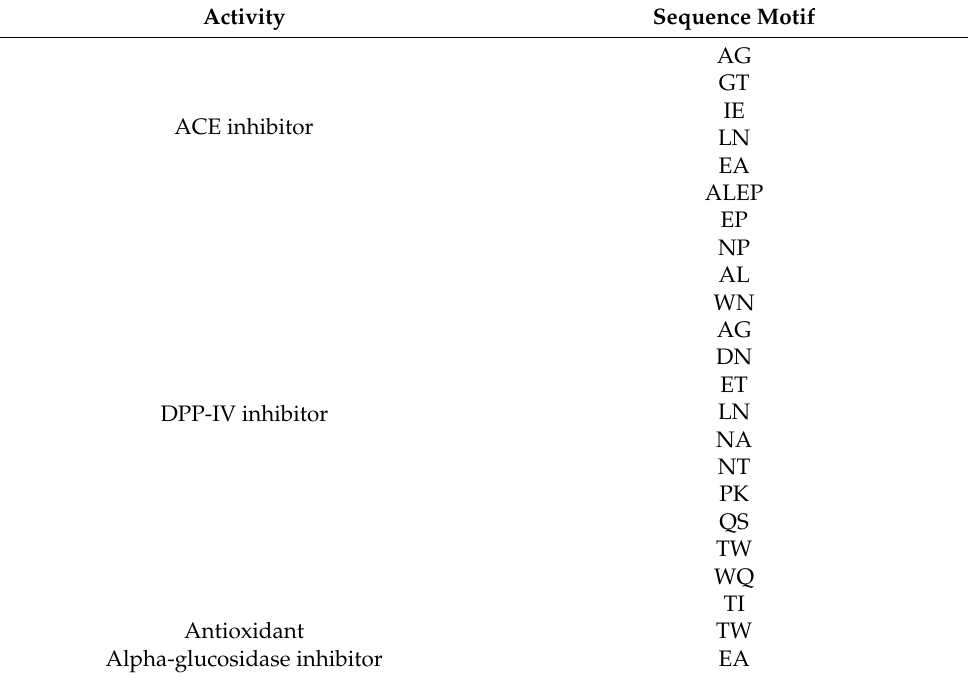
Figure 4. In vitro antioxidant power evaluation of BT13 by DPPH assay. The data points represent the means ± SD of four independent experiments in triplicate. Data were statistically analyzed by one-way ANOVA followed by Tukey’s post-hoc test. (*) p < 0.5; (**) p < 0.1; (***) p < 0.001. ns: not significant; C: control sample. Table 1. Screening of the T13 activity using BIOPEP database (www.uwm.edu.pI/biochemia). T13 Peptide sequence: